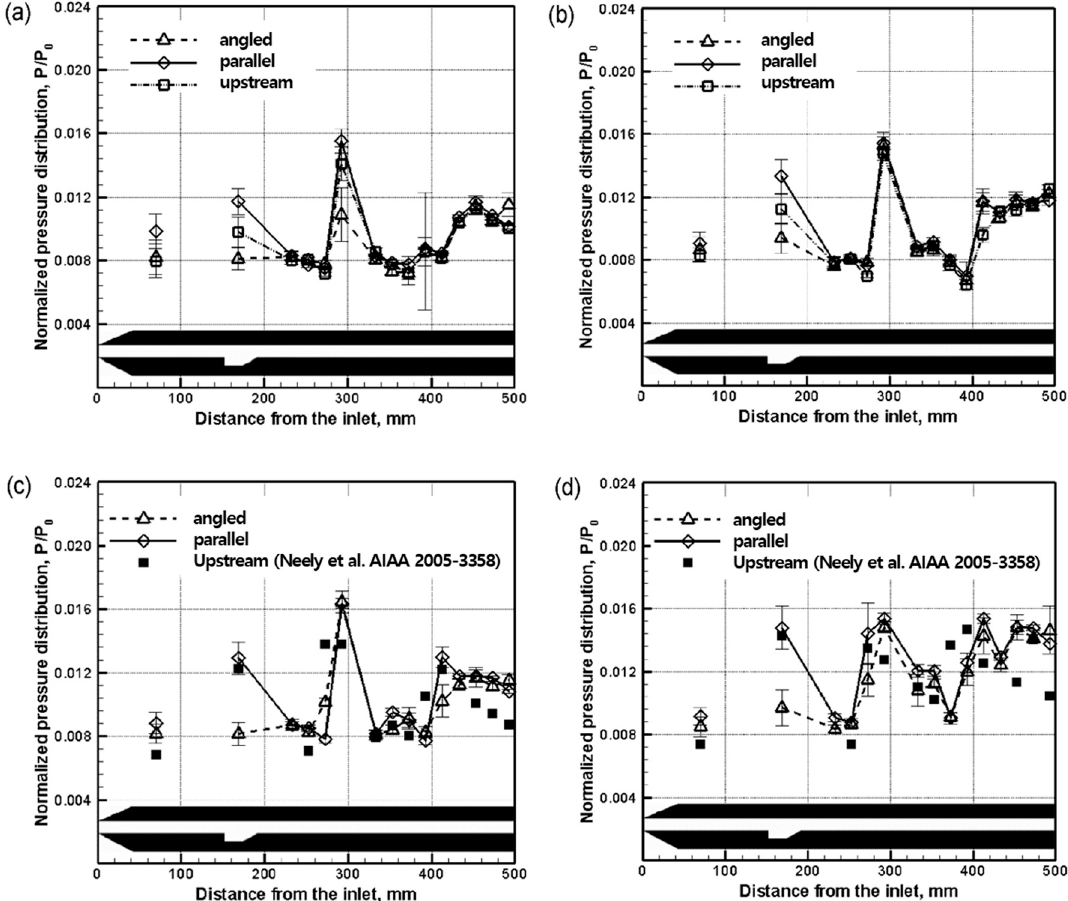
Figure 5. Wall pressure distribution of three different fuel injections: ( a ) non-reacting flow, Φ = 0.13; ( b ) reacting flow, Φ = 0.13; ( c ) non-reacting flow, Φ = 0.44; ( d ) reacting flow, Φ = 0.44.